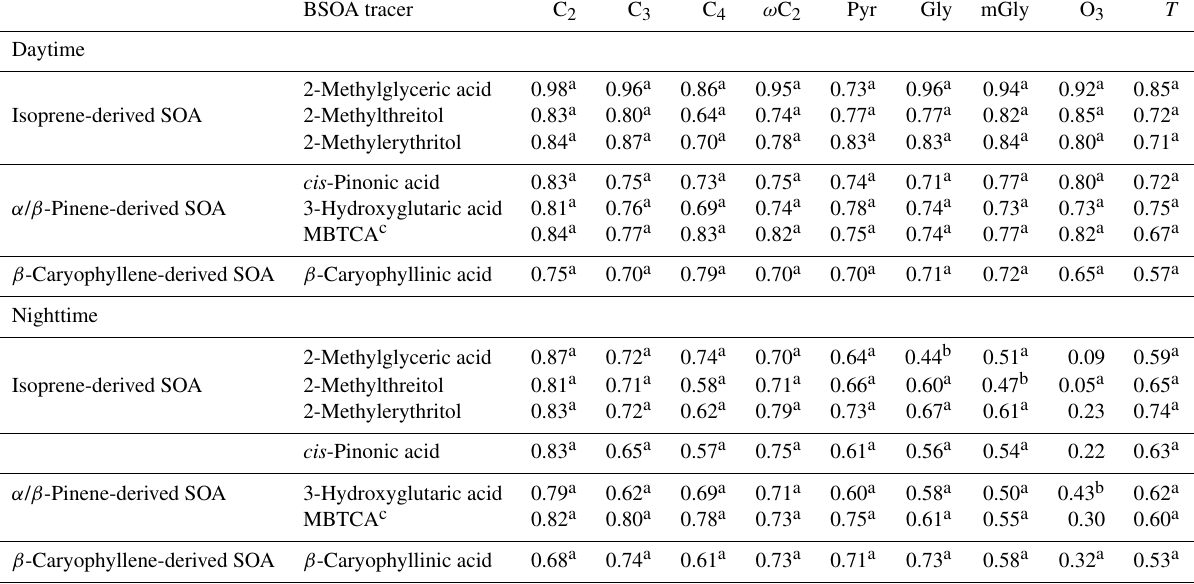
Table 4. Correlation coefficients ( R ) matrix among major low molecular weight dicarboxylic acids and related SOA, BSOA tracers, temper- ature ( T ) and O 3 concentrations at Mt. Tai during the summer